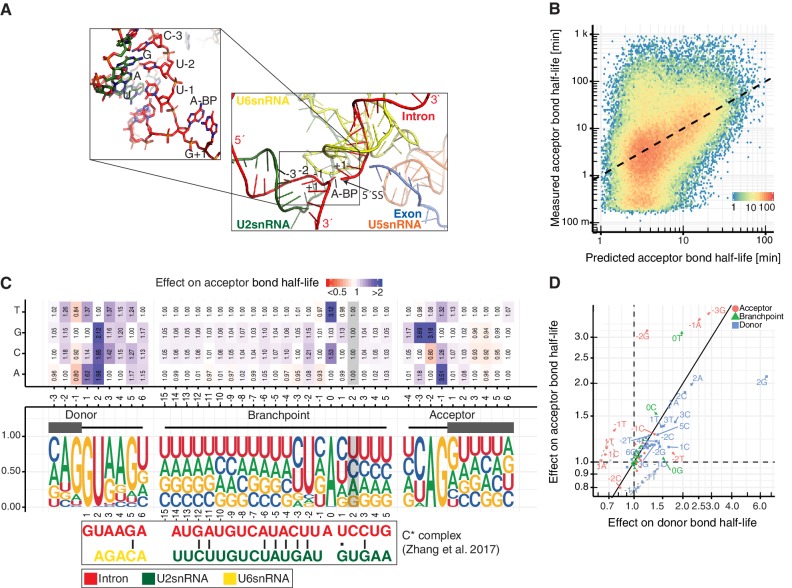
Sequence and structural contributions to acceptor bond half-life (related to the first and second catalytic steps).(A) Structure of U2, U5 and U6 snRNAs interactions with precursor RNA in C* spliceosome complex (Zhang et al., 2017). (B) Measured acceptor bond half-life against single nucleotide model prediction (median relative error of 150%, Spearman's rank correlation ρ = 0.45, p<10−16). (C) Nucleotide frequency (middle track) and prediction of the relative effect on acceptor bond half-life (upper track) for single nucleotide deviation from consensus sequence in sequence around donor, acceptor splice-site and branchpoint. Grey color marks positions predicted to have no effect (Materials and methods). RNA map of base-pairing interactions between two snRNAs (U2 and U6) and precursor RNA sequences used in the published spliceosome structures of C* complex (intron (red), U2 snRNA (green), U6 snRNA (yellow)). Canonical and non-canonical base-pairing interactions are depicted by black solid lines and black dots, respectively. (D) Comparison of the effects of single nucleotide changes on donor bond half-life against effects on acceptor bond half-life. Donor (blue), acceptor (red), branchpoint (green) single nucleotide effects are shown. Positions one nt before the donor site and one nt after the acceptor site are encircled in grey. (C, D based on Supplementary file 4).